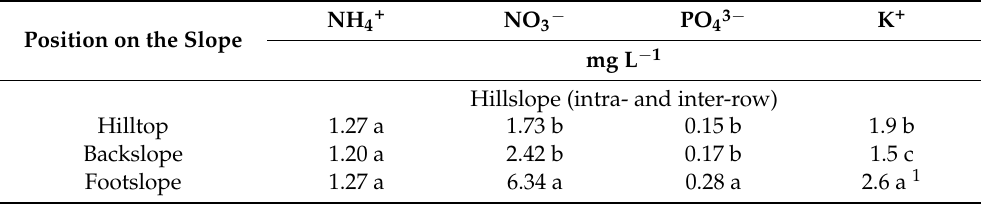
Table 1. Mean concentrations of major plant nutrient ions in leachates collected monthly for two years (2 November 2020–25 November 2022) from wick lysimeters installed at vineyard hilltop, backslope and footslope. Data represent mean values of all leachate samples from each slope position (intra- and inter-row data are